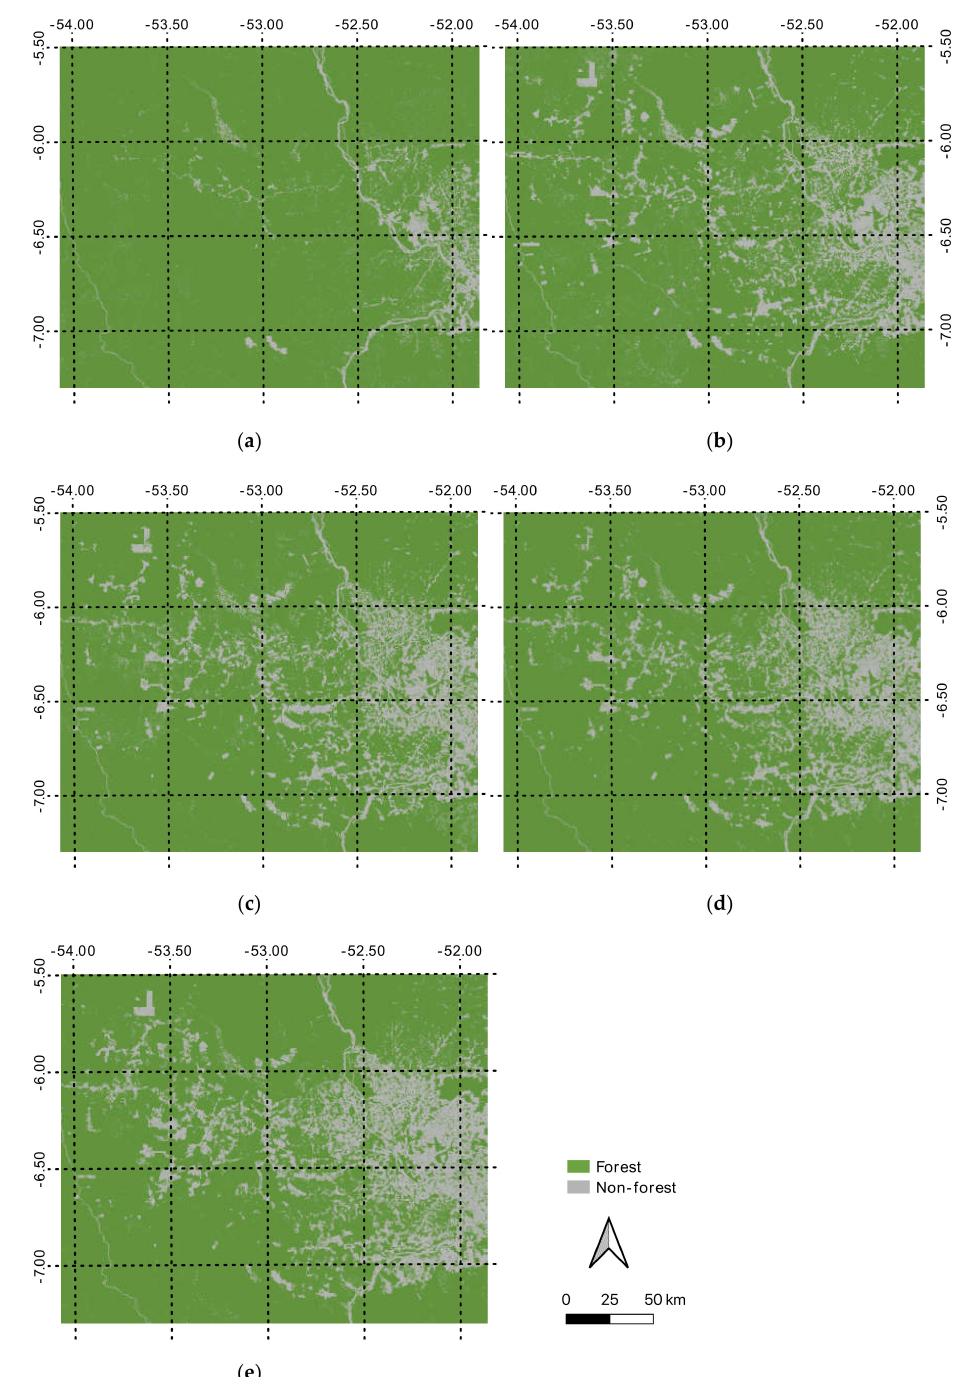
Figure 4. ( a ) Classification result derived from Landsat 7 for 2000; ( b ) Classification result derived from Landsat 5 for 2006; ( c ) Classification result derived from Landsat 5 for 2010; ( d ) Classification result derived from Landsat 8 for 2015; ( e ) Classification result derived from Sentinel-2 for